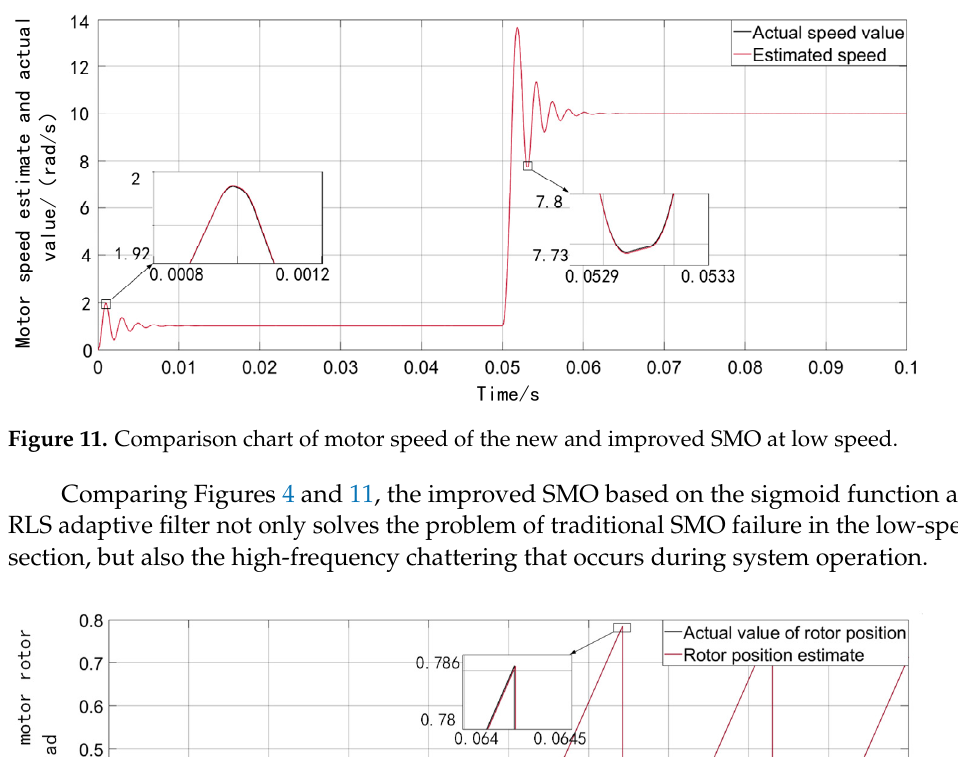
Figure 11. Comparison chart of motor speed of the new and improved SMO at low speed.